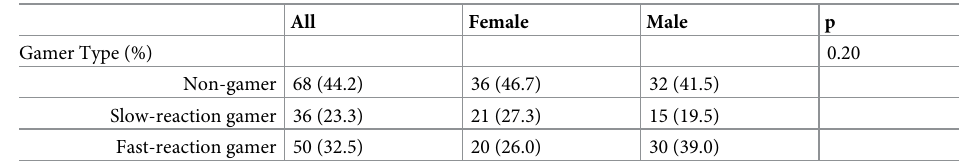
Table 3. Gamer type in this sample.